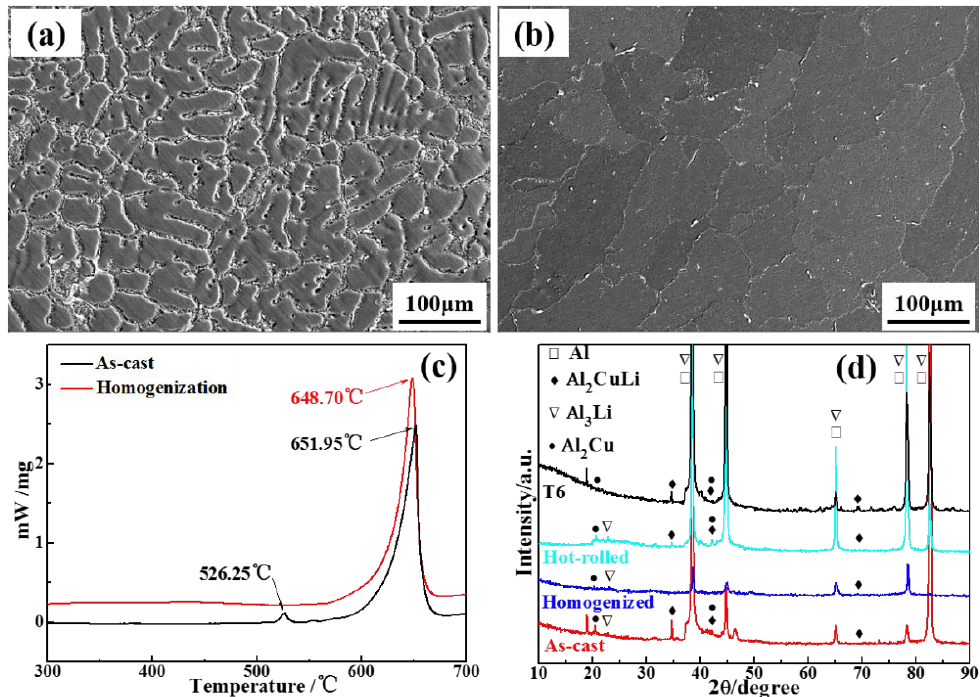
Figure 2. Microstructure characteristics and XRD results of Al-3.2Cu-1.5Li-0.1Sc alloy: ( a ) As-cast microstructure; ( b ) Homogenized microstructure; ( c ) DSC curve of as-cast and homogenized alloy; ( d ) XRD results of alloy in different states.